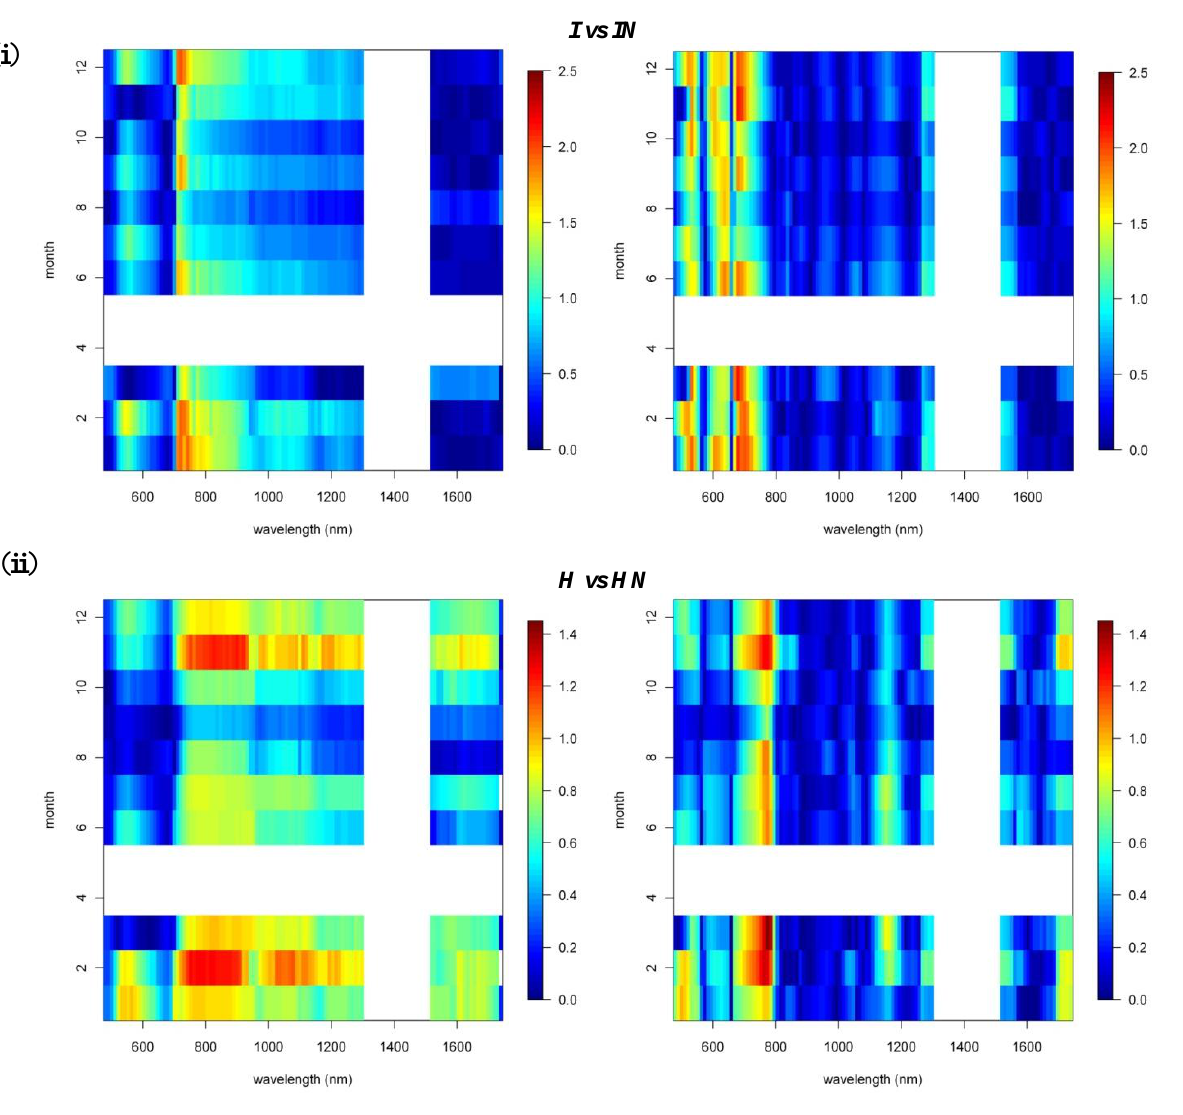
Figure 3. Reflectance and 1 st -d reflectance spectro-temporal Separability Index chart for the pairwise comparison of ( i ) invasives and ( ii )